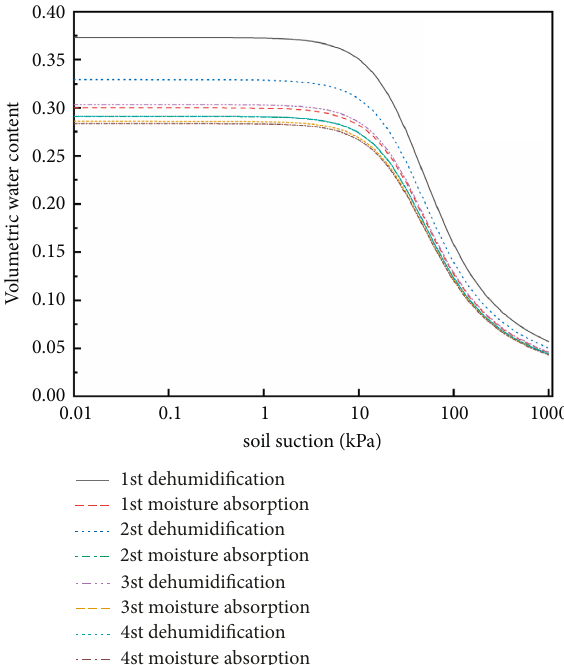
Figure 3: Water-soil characteristic curves for different number of cycles.